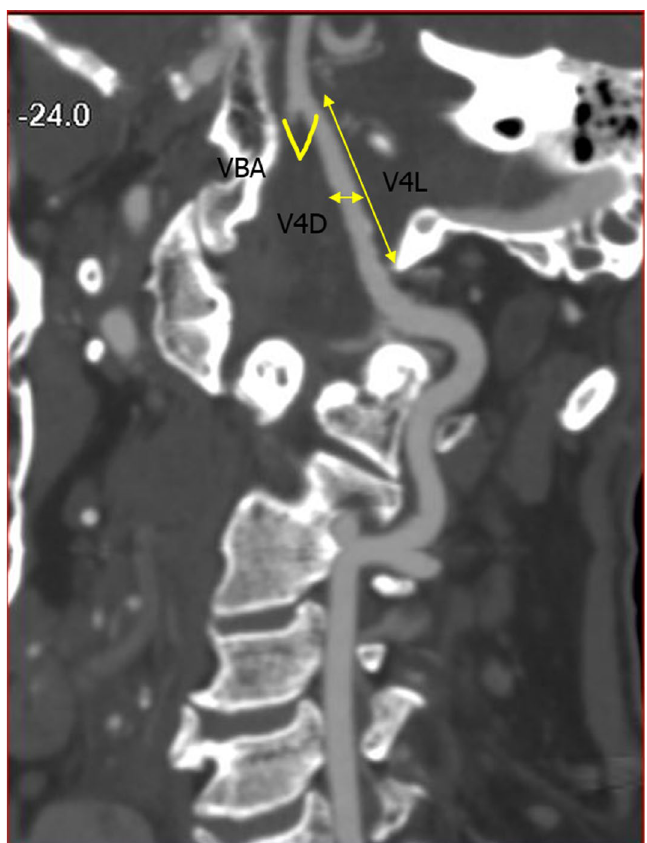
Figure 1. Oblique view of CTA image, showing the V3 and V4 segments of the VA. V4L length of the V4 segment; V4D Diameter of the V4 segment; VBA the angle at the vertebrobasilar